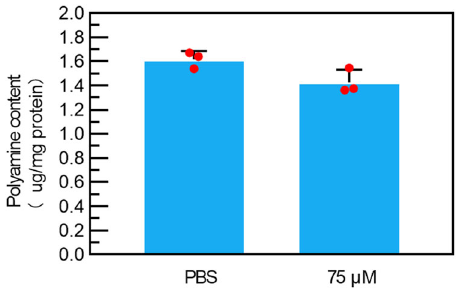
Fig. 10 The spermine determination by HPLC. HPLC analysis was used to detect the intracellular spermine concentration in DU145 cells ( n = 3, mean ±